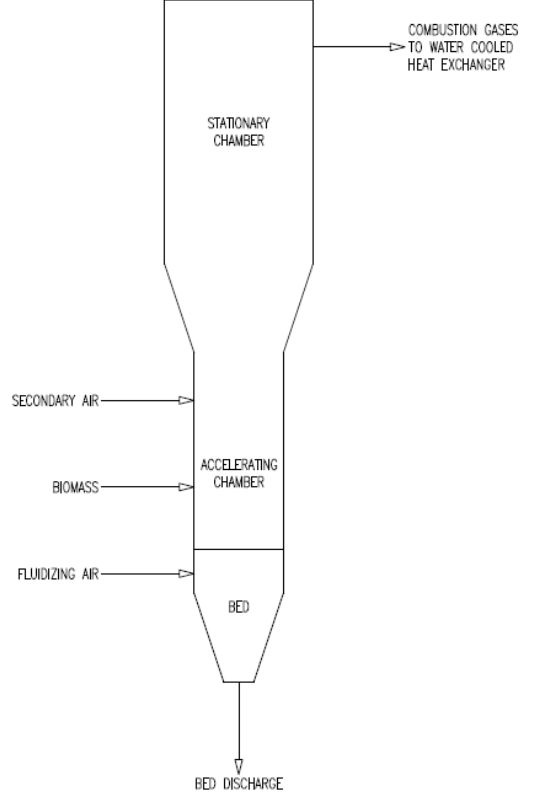
Figure 1. The heat exchanger was positioned downstream the oxidating chamber and produced approximately 500 kWt. Thermal power is provided to the user through the superheating of the water. The two combustion chambers (accelerating and stationary flue gas) are connected as represented.